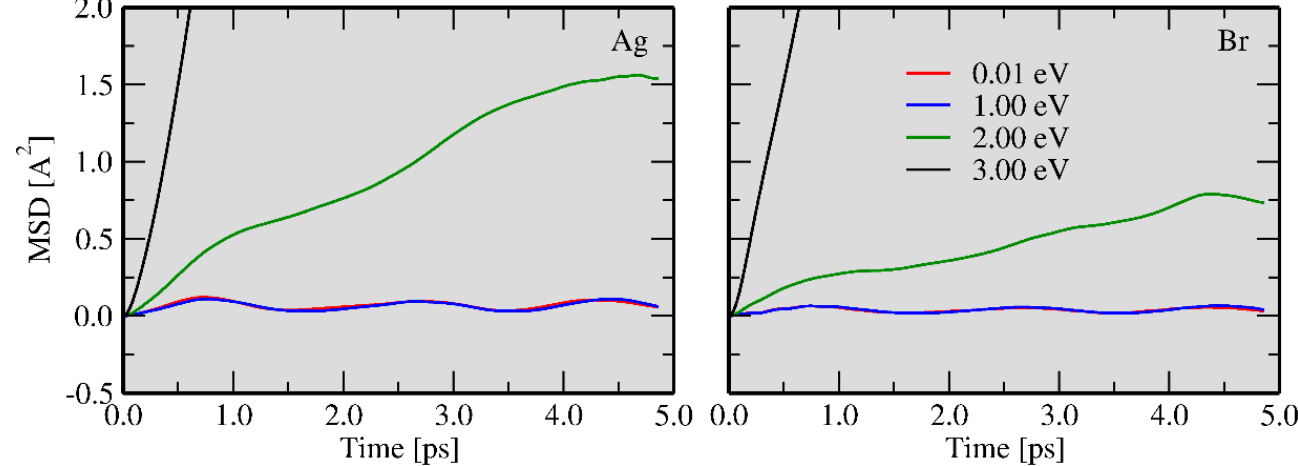
Figure 7. Mean square displacement for Ag ( left panel) and Br ( right panel) as a function of the electronic temperature.